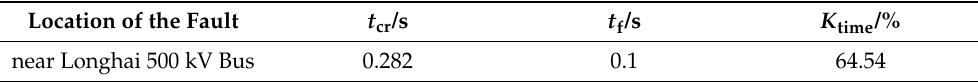
Table 5. The minimum critical clear time of fault in Qujing Power Grid.